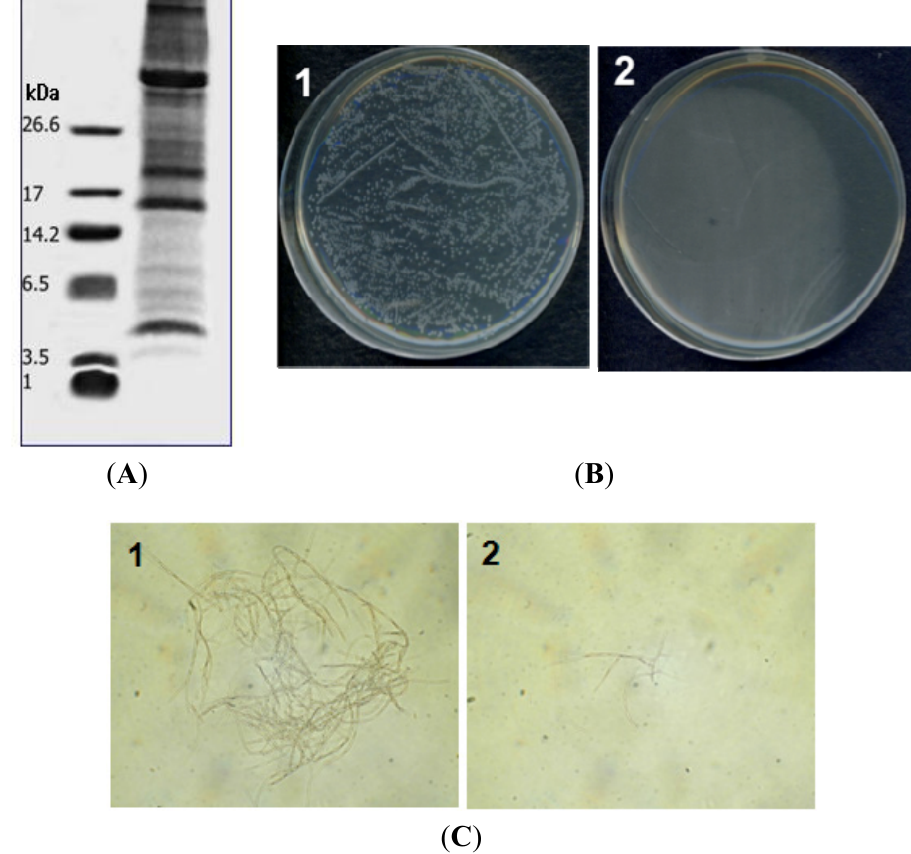
Figure 1. ( A ) Tricine gel electrophoresis of proteins extracted from potatoes. Total proteins were extracted from potato tubers using extraction buffer (10 mM Tris-HCl, 1.5 M LiCl, pH 7.4): lane 1, molecular size markers (26.6, triosephosphate isomerase; 17, myoglobin; 14.2, α -lactalbumin; 6.5, aprotinin; 3.5, insulin chain B; 1, bradykinin); lane 2, proteins extracted from potato (20 μ g); ( B ) Antibacterial activities of proteins extracted from potato against the bacterial strain Clavibacter michiganensis subsp . michiganensis : 1, untreated cells; 2, cell treated with 100 μ g of protein (<10 K fraction); ( C ) Antifungal activity against Rhizoctonia solani : 1, untreated cells; 2, cells treated with 200 μ g of protein (<10 K fraction). Measurements were made in